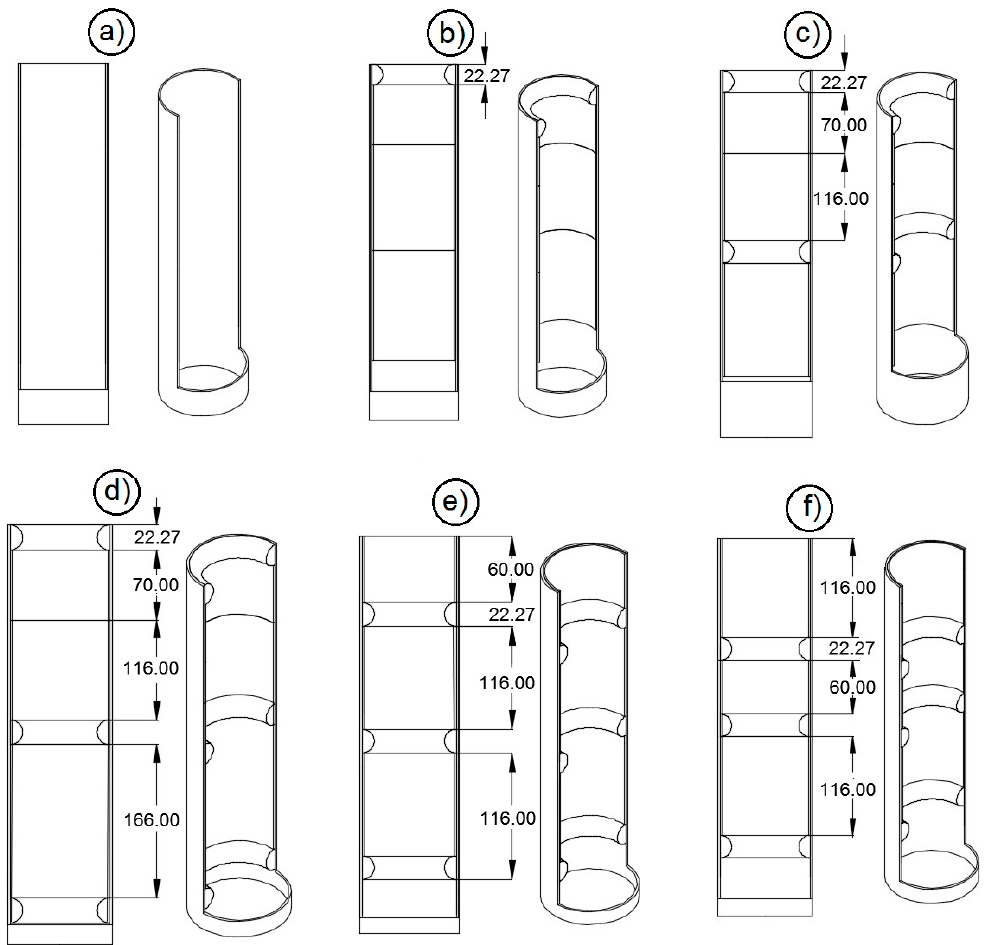
Figure 4. Variants of the position of diffusion rings separated by diffuser spacer sleeves—configurations used in laboratory investigations. ( a ) smooth surface; ( b ) one diffusion ring; ( c ) two diffusion rings; ( d ) three diffusion rings with a 166 mm spacer sleeve at the bottom; ( e ) three diffusion rings with a 60 mm spacer sleeve on top; ( f ) three diffusion rings with a 116 mm spacer sleeve on top;